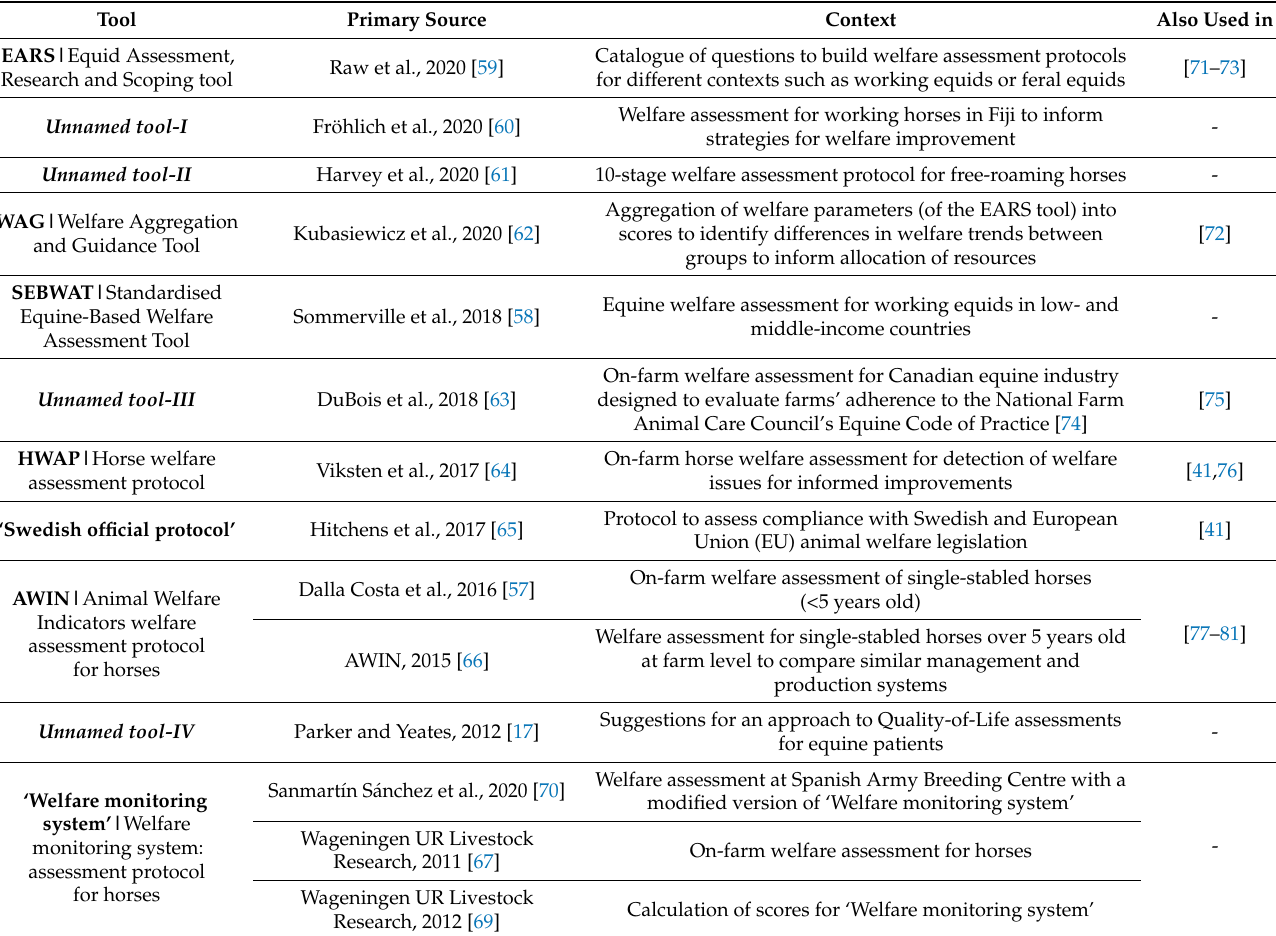
Table 1. Analysed welfare and QoL assessment tools with the context they were used in or were de- signed for, the publications the analyses were based on (primary source) and additional publications using the tool that was identified in the literature search, but not included in the analysis.